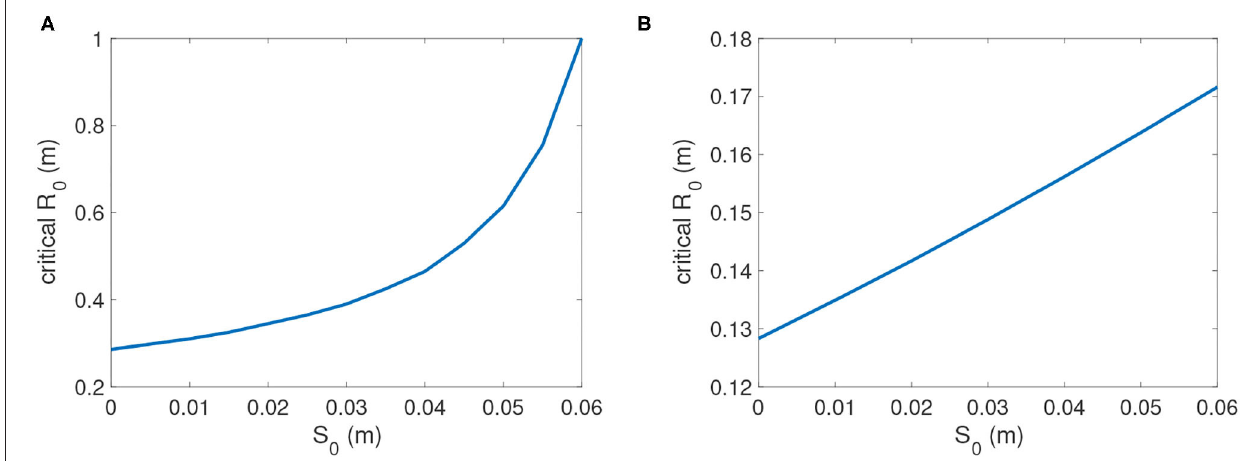
FIGURE 10 | Critical reef height R 0 c as a function of initial sediment height S 0 . (A) P = 221; (B) P = 1,000. Other parameters are as in Table 2 .